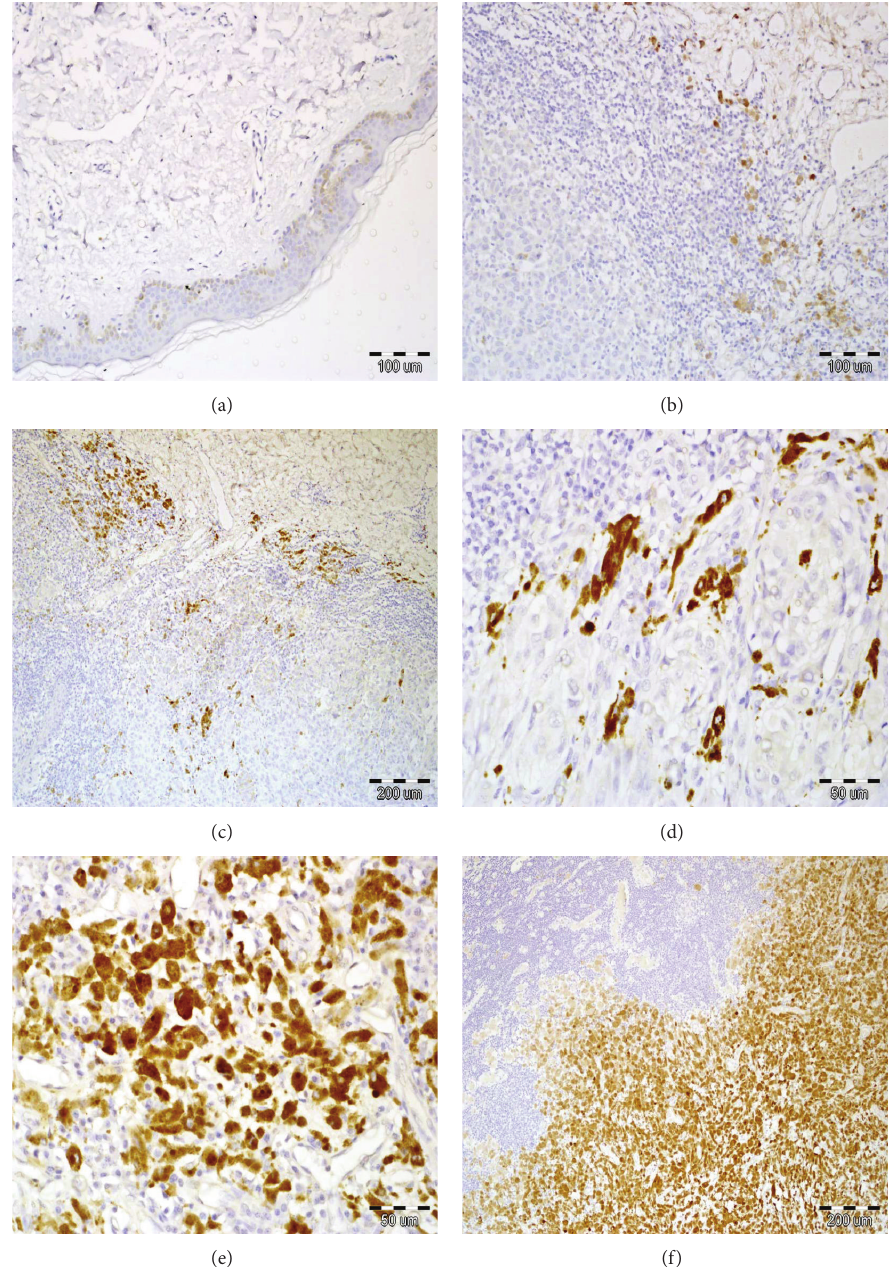
Figure 1: Immunohistochemically visualized expression of ADAM-10 in cutaneous melanoma. Lack of ADAM-10 immunoreactivity in normal skin ((a), 200x, hematoxylin). Low percentage of ADAM-10-positve cells in cutaneous melanoma with brisk tumor-infiltrating lymphocytes ((b), 10% of ADAM-10 positive cells, 200x; (c), hematoxylin, 30% of ADAM-10 positive cells, 200x, hematoxylin). Intermediate percentage of ADAM-10 positive cells in cutaneous melanoma with nonbrisk tumor-infiltrating lymphocytes ((d), 40% of ADAM-10 positive cells, 400x). Enhanced ADAM-10 immunoreactivity in melanoma cells with scanty tumor-infiltrating lymphocytes ((e), IRS 12, 400x, hematoxylin). High cytoplasmic reactivity of ADAM-10 in regional lymph node metastases ((f), 200x,